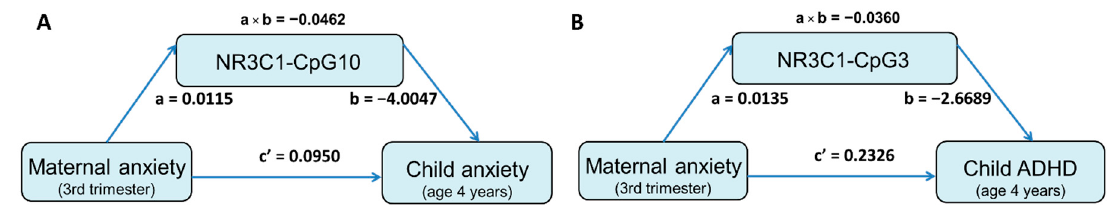
Figure 4. Mediation analyses on the association between exposure to prenatal maternal stress and child Behavioral measures. ( A ) The methylation level of NR3C1-CpG10 negatively mediated the effects of maternal anxiety during the third trimester on children’s anxiety (95% CI = ( − 0.1306) − ( − 0.0006)). ( B ) The methylation level of NR3C1-CpG3 negatively mediated the effects of maternal anxiety during the third trimester on children’s ADHD (95% CI = ( − 0.1190) − ( − 0.0019)).